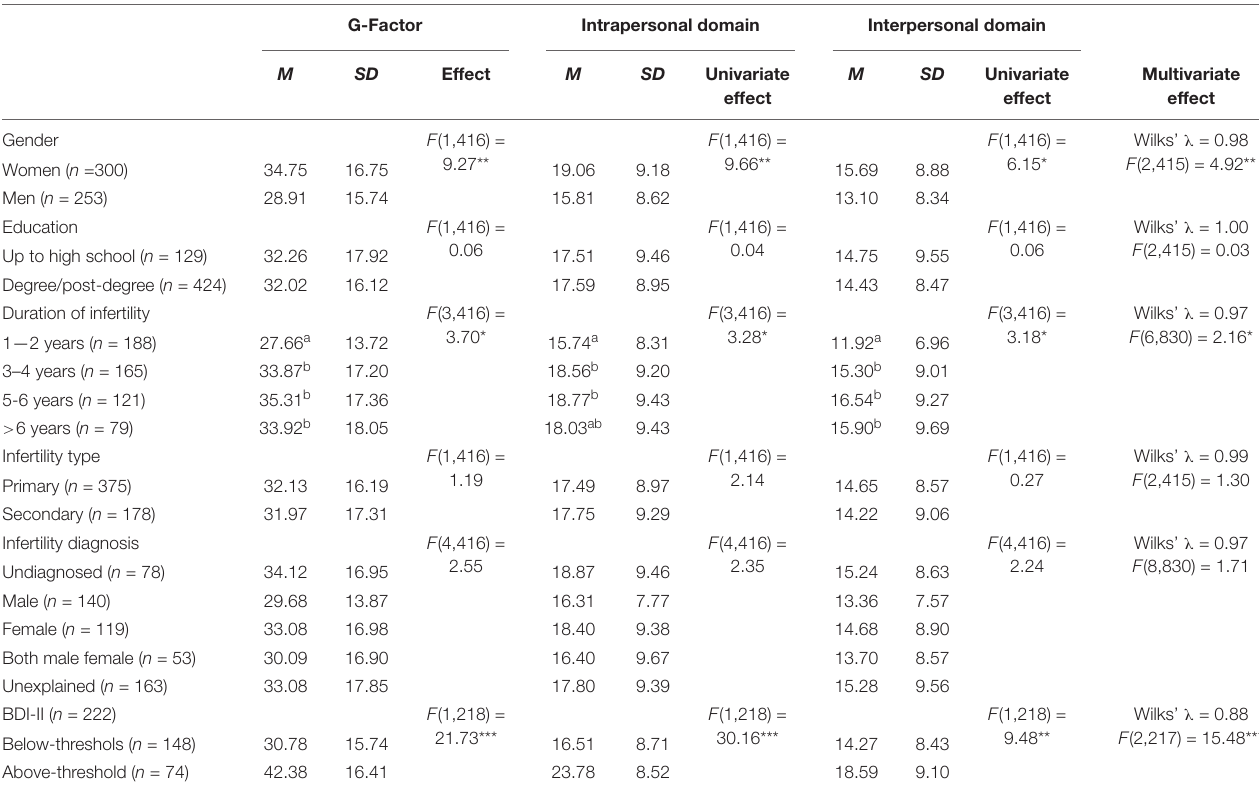
TABLE 4 | Comparisons between groups in IRSS-BP scores ( n = 553).